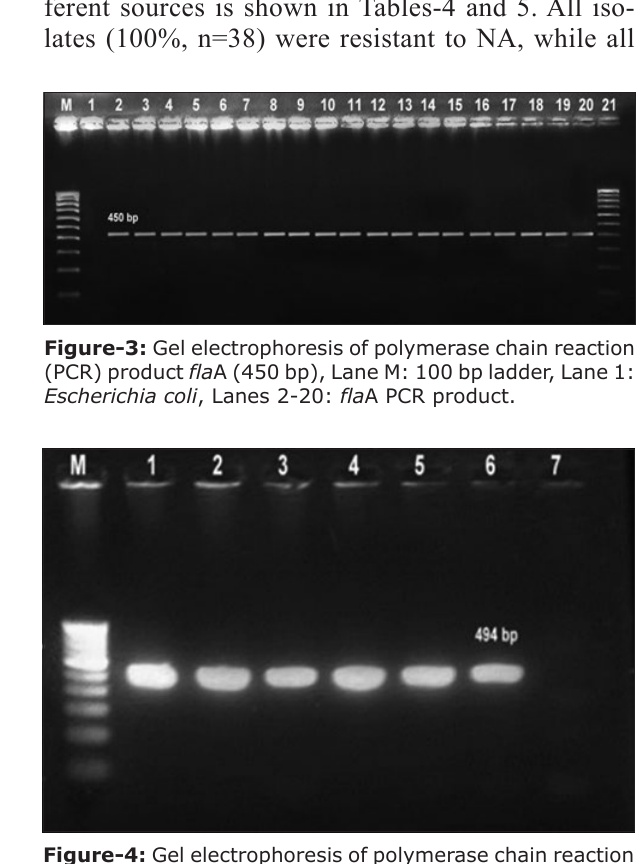
Figure-4: Gel electrophoresis of polymerase chain reaction (PCR) product vir B11 (494 bp), Lane M: 100 bp ladder, Lane 7: Escherichia coli , Lanes 1-6: vir B11 PCR